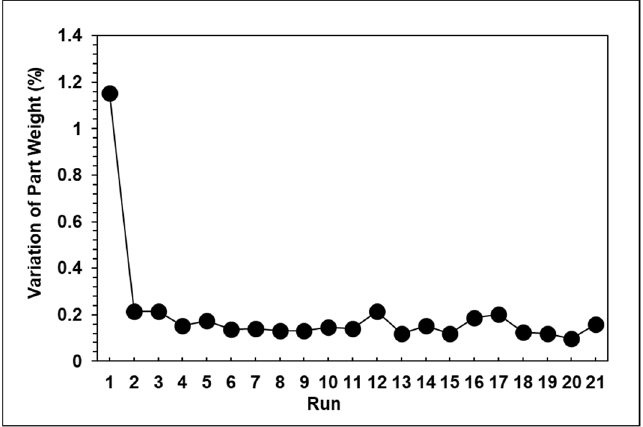
Figure 15. Variations in product weight after three seconds of packing time.